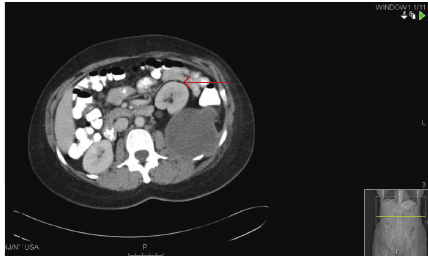
Figure 3: Red arrow pointing to the displaced left kidney by the soft tissue mass.